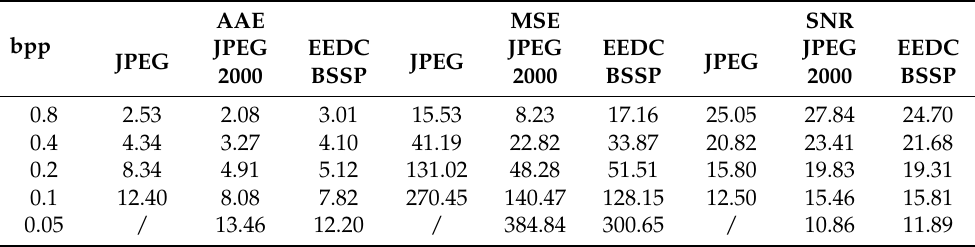
Table 12. Results of the AAE, MSE, and SNR metrics for image beauty .